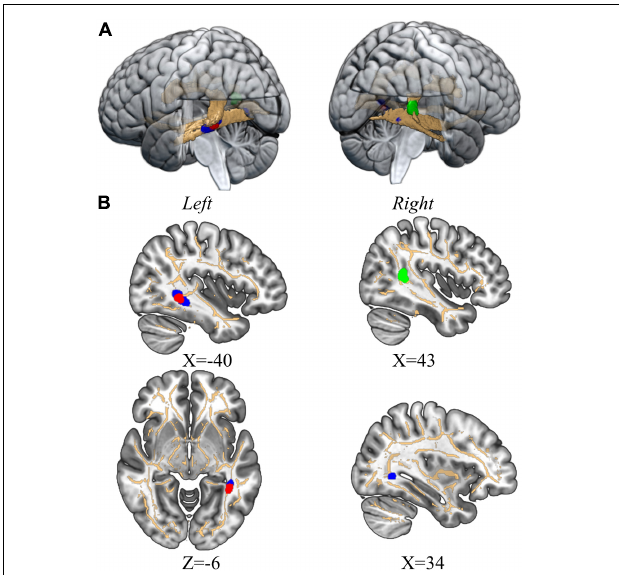
FIGURE 2 | The significant clusters in the tract-specific TBSS analysis. (A) The 3D view. The binary mask of TOI is copper while the significant clusters in the comparison of FA, MD, and AD is in red (FA), green (MD), and blue (AD) respectively. (B) The cross-section view. The mean FA skeleton is copper and significant clusters emphasized via TBSS-fill is set as the same color in 3D